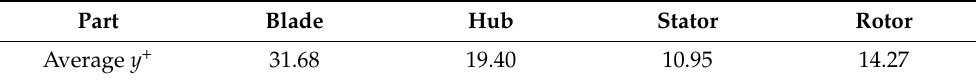
Table 1. Average y + of each